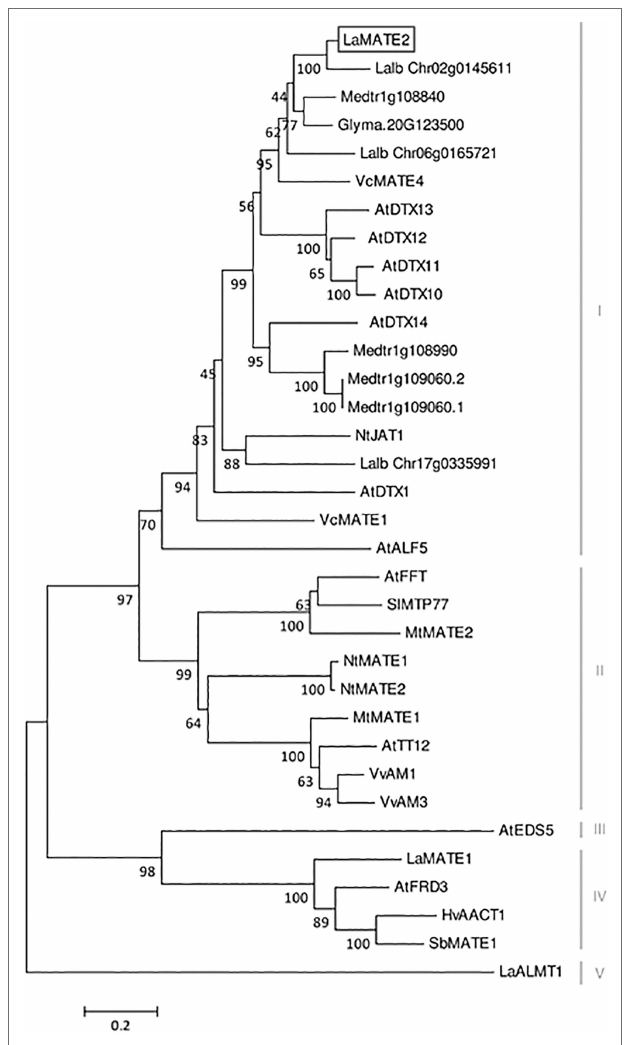
FIGURE 3 | Phylogenetic tree of MATE transporters. A phylogenetic analysis was performed using the LaMATE2 amino acid sequences of Lupinus albus (LaMATE1, LaMATE2, Lalb_Chr17g0335991, Lalb_Chr06g0165721, Lalb_ Chr02g0145611, LaALMT1); AtFRD3 AtEDS5, AtTT12, AtDTX1,10,11,12,13,14, AtALF5 and AtFFT of Arabidopsis thaliana ; Glyma.10G267700 of Glycine max ; HvAACT1 of Hordeum vulgare ;